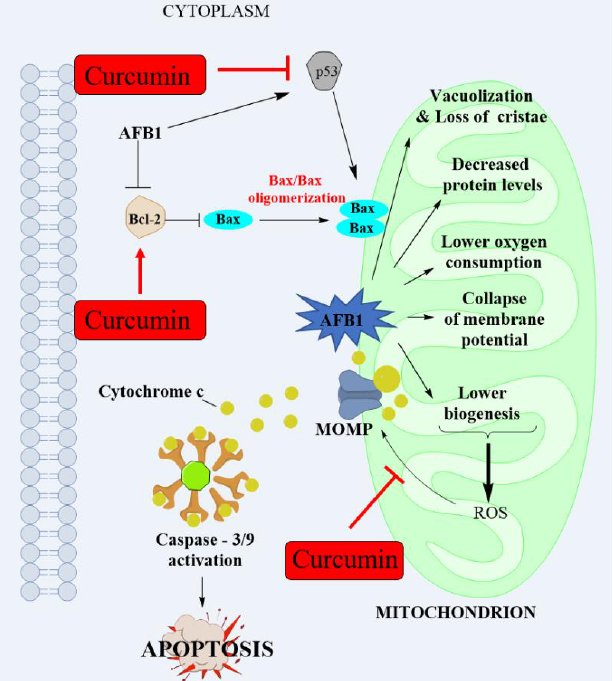
Figure 4. AFB1 exposure induces mitochondrial dysfunction and mitochondrial apoptosis and the modulated effects of curcumin.